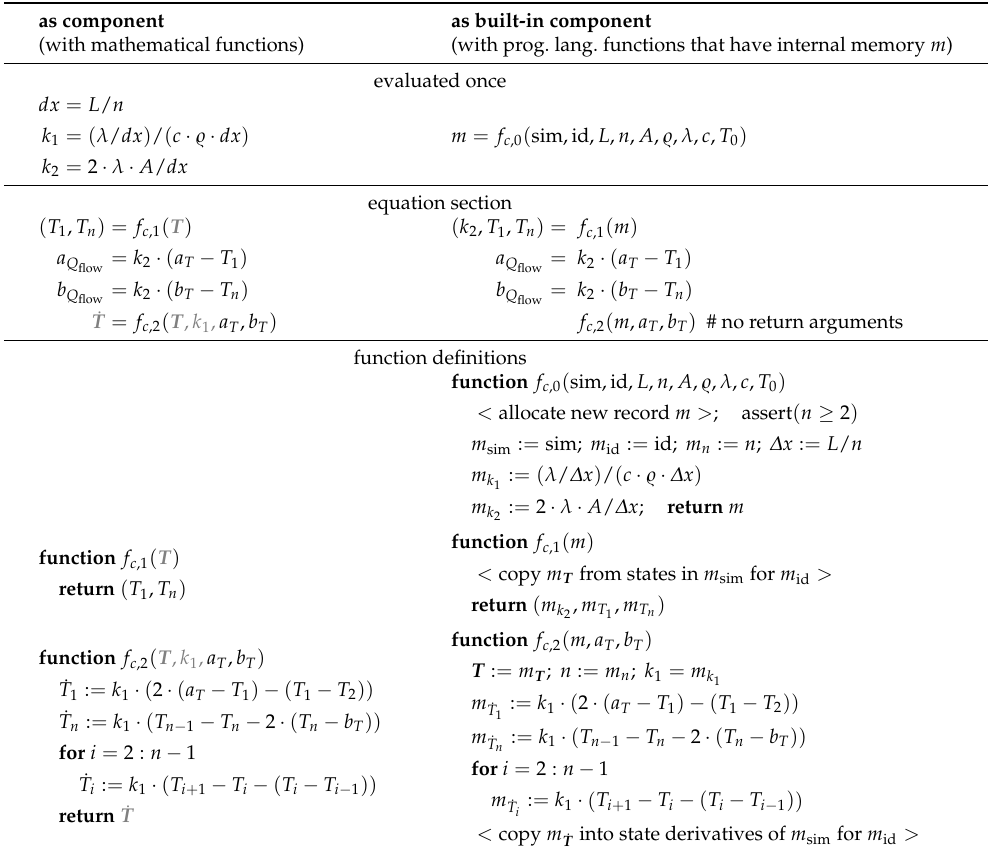
, b Q (heat flow rates). flow flow